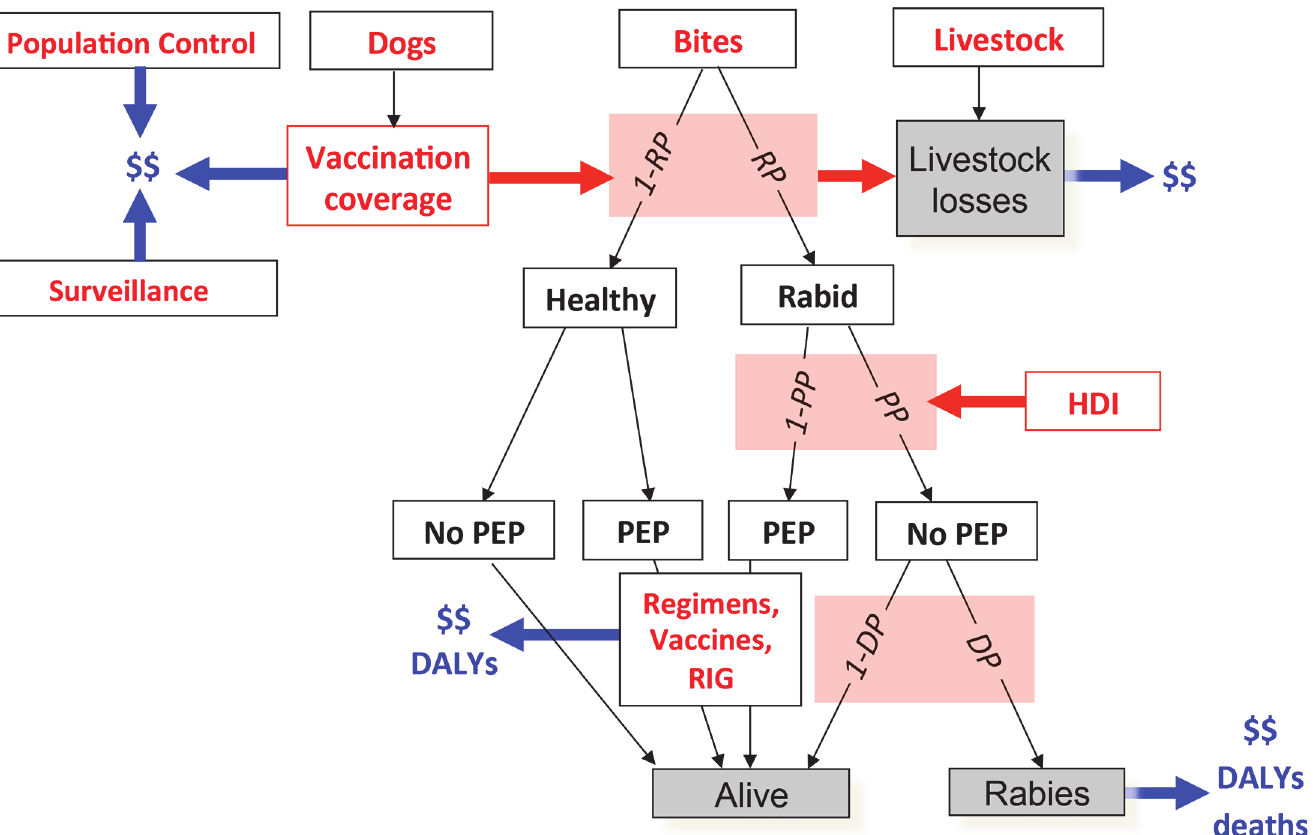
Fig 1. Model framework used in this study for estimating the global burden of canine rabies. Probability steps correspond to the probability that a bite is by a rabid animal ( RP); that the victim received post-exposure prophylaxis, PEP, ( PP) ; and, in the absence of PEP, that the bite victim developed rabies ( DP) . Data inputs (Table 1) are shown in red and model outputs in blue. Red arrows show estimated relationships (Fig 2). DALY = Disability-Adjusted Life Year; HDI = Human Development Index. Further details are given in Table